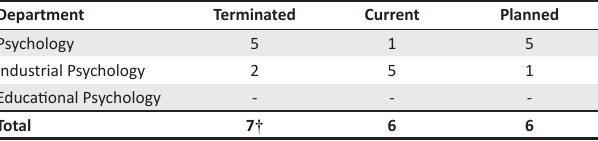
TABLE 4: Number of programmes terminated, current or planned per type of university